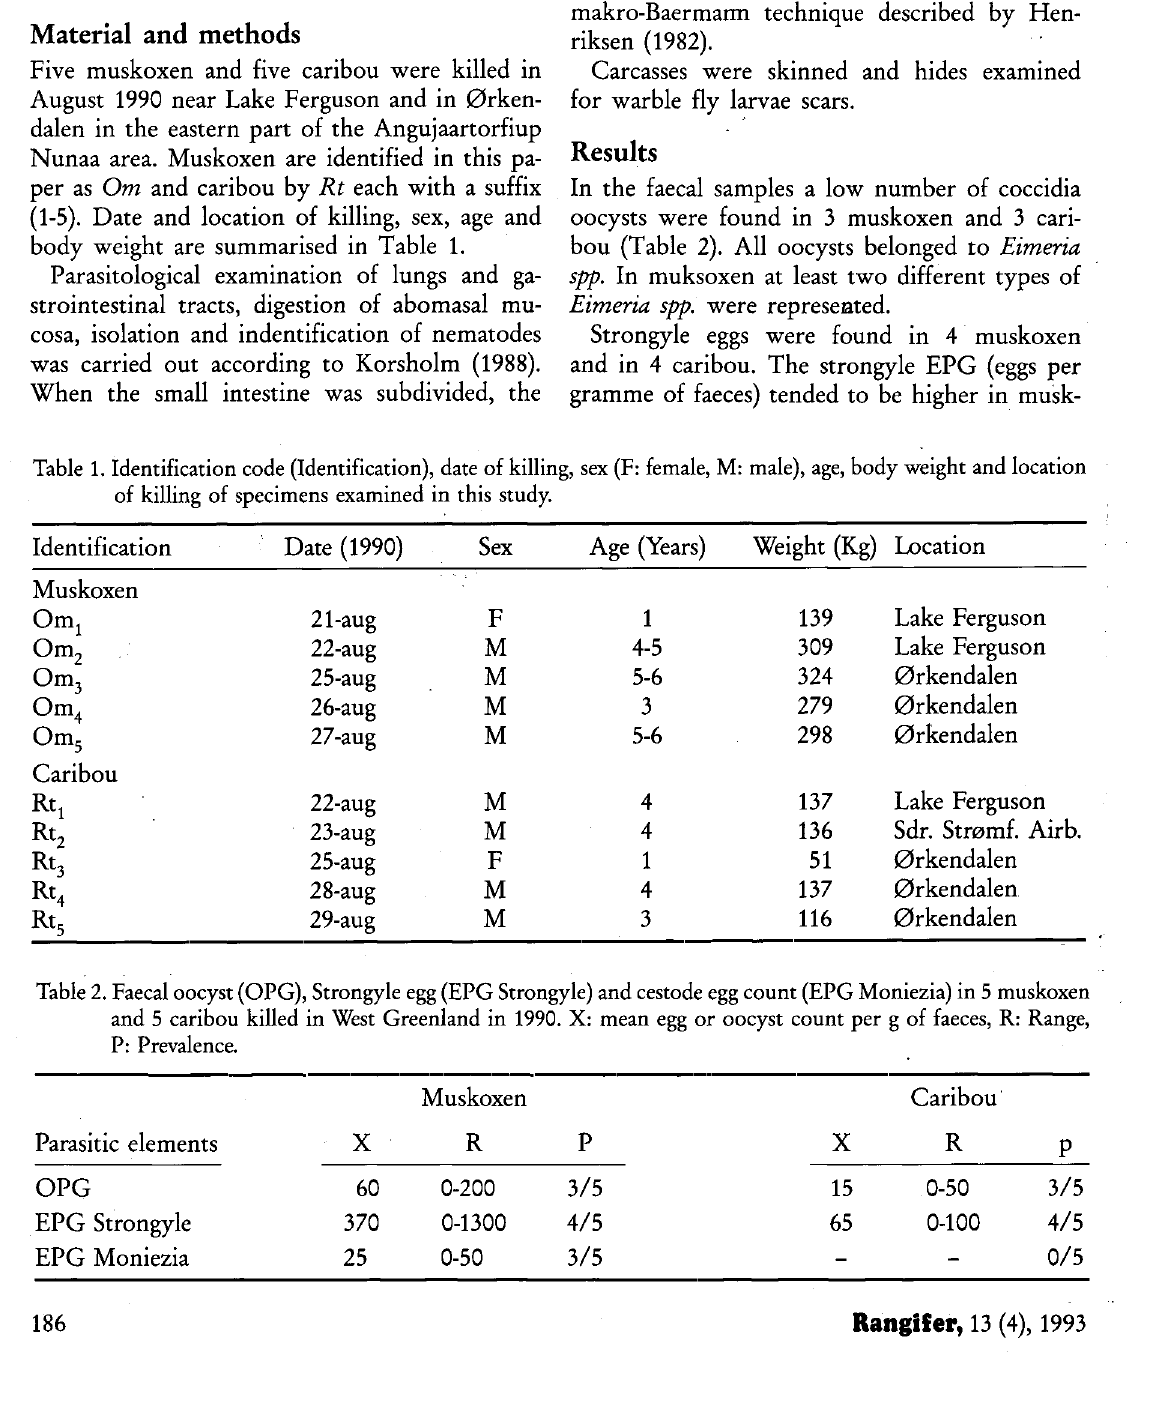
Table 2. Faecal oocyst (OPG), Strongyle egg (EPG Strongyle) and cestode egg count (EPG Moniezia) in 5 muskoxen and 5 caribou killed in West Greenland in 1990. X: mean egg or oocyst count per g of faeces, R: Range, P: